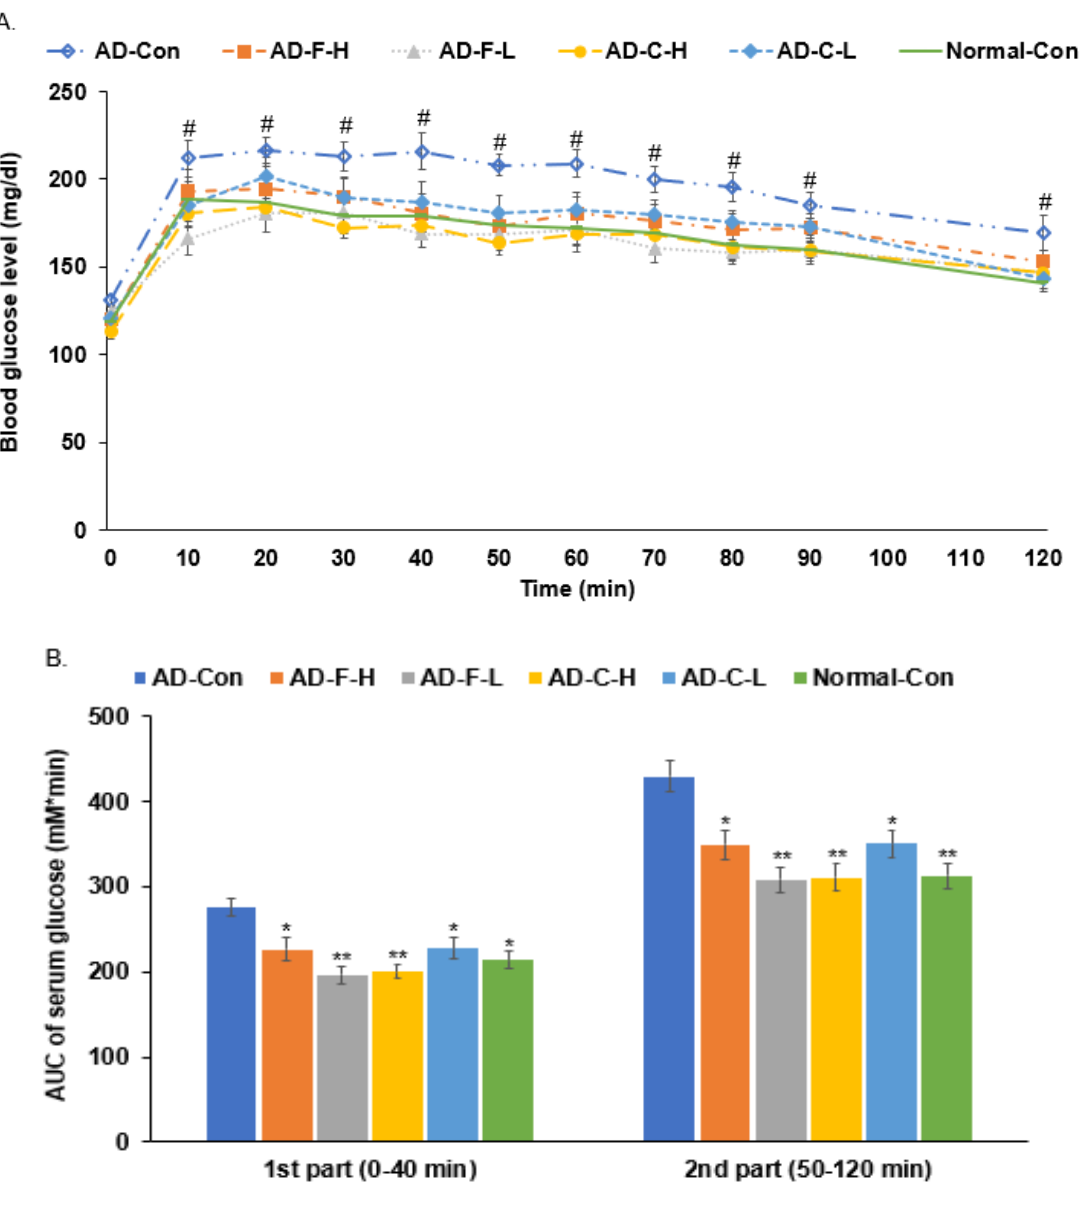
Figure 3. Serum glucose concentrations during oral glucose tolerance test. ( A ) Serum glucose levels at an assigned time after the glucose challenge (2 g/kg body weight). Treatment effect at p < 0.01, time effect at p < 0.01, and interaction between treatments and time at p < 0.01 on serum glucose concentrations by one-way repeated ANOVA. # Significant treatment effects at p < 0.05. ( B ) The area under the curve (AUC) of glucose in the first (0–40 min) and second phases (50–120 min). The dots or bars and error bars represent the means ± standard deviations (n = 10). Hippocampal amyloid- β (25–35) infused rats were fed a high-fat diet containing dextrin (AD-Con), fucoidan with high molecular weight (AD-F-H), fucoidan with low molecular weight (AD-F-L), λ -carrageenan with high molecular weight (AD-C-H), and λ -carrageenan with low molecular weight (AD-C-L). The rats in the Normal-Con group had hippocampal saline infusion to have no amyloid- β deposition and were fed a high-fat diet (Normal-Con). * Significant from the AD-Con group at p < 0.05 and ** at p < 0.01.